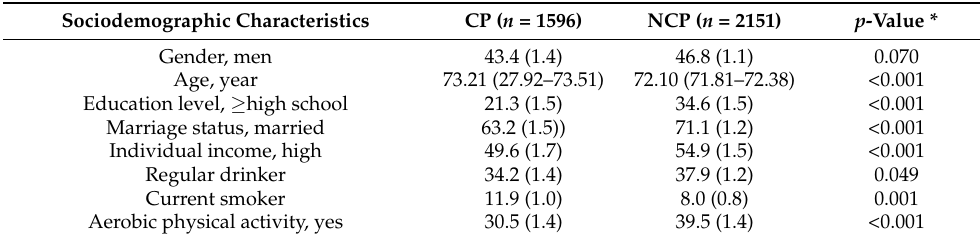
Table 1. Sociodemographic characteristics by chewing problems in Korean elderly individuals.